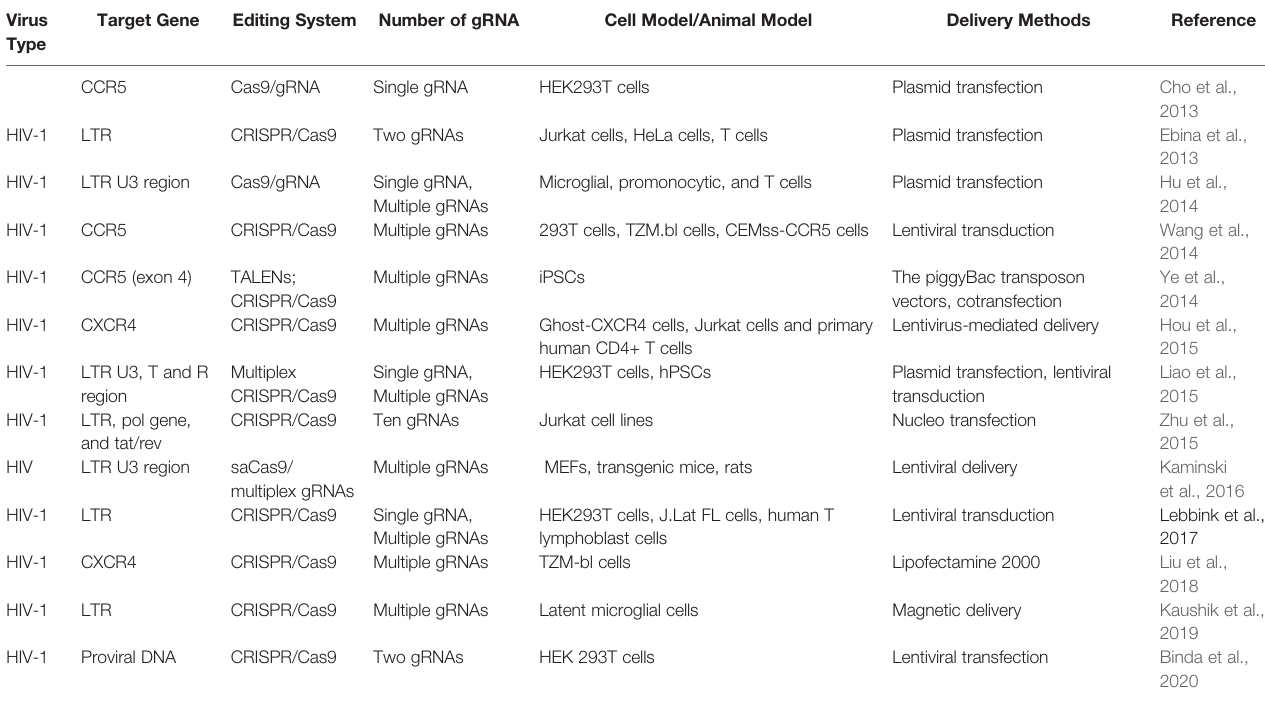
TABLE 1 | Applications of CRISPR/Cas9 system for gene therapy of HIV